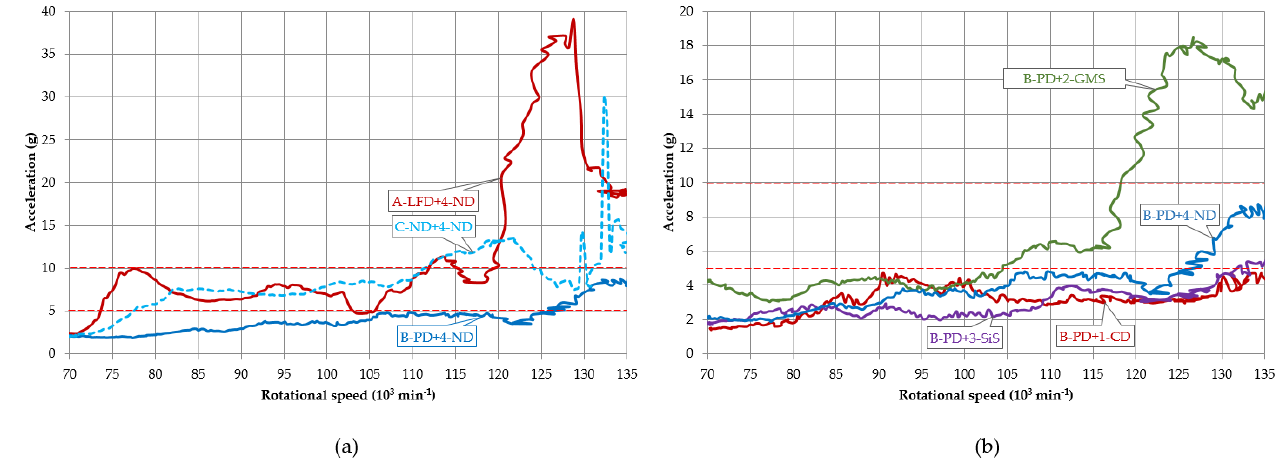
Figure 11. Dynamic response for generated vibration amplitudes above 5g ( a ) pressure plate, ( b ) rotor casing. ( b ) rotor